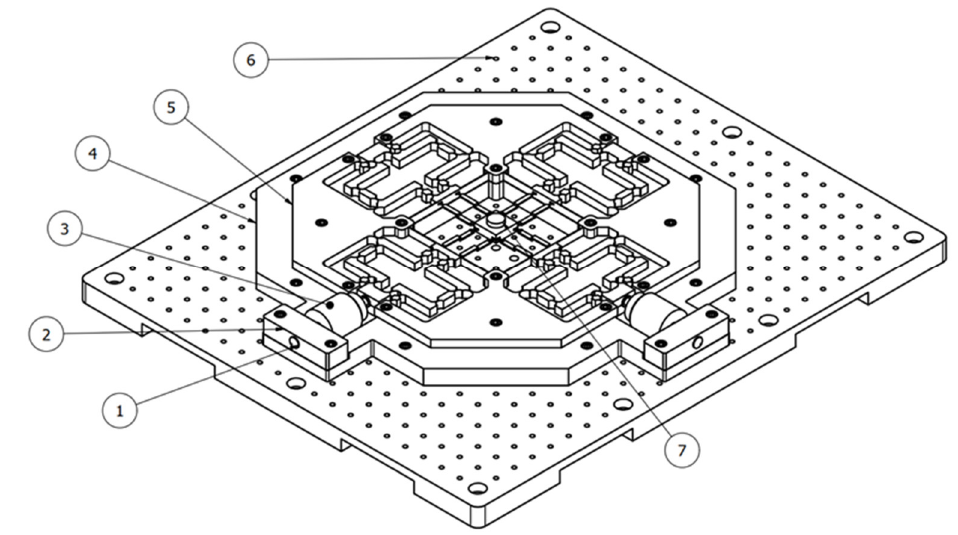
Figure 3. Assemble diagram of XYZ micropositioner: (1) preload screw, (2) PZT mounting plate, (3) PZT actuator, (4) intermediate plate, (5) prototype, (6) anti-vibration fixing plate, (7) specimen. The main parameters of the XYZ micropositioner are given in Figure 4 and Table 1.